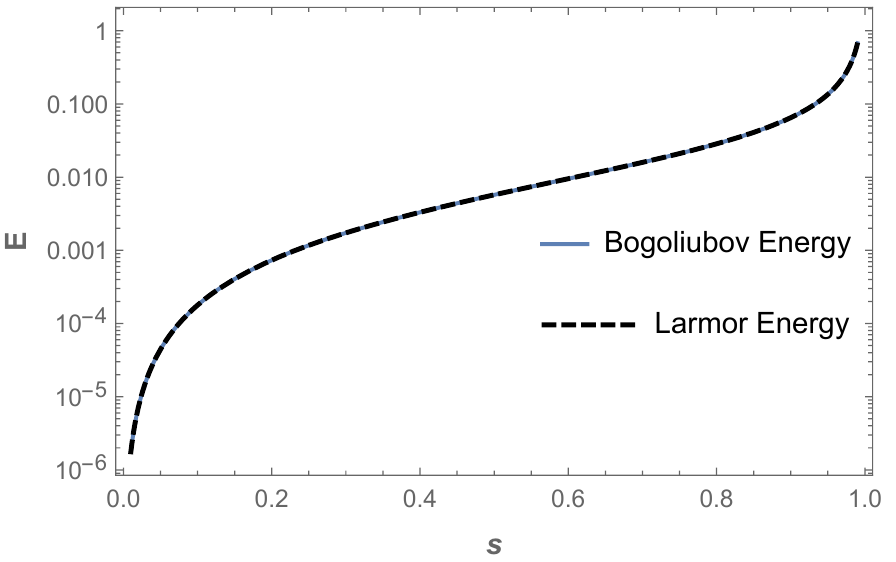
Figure 4. The Larmor energy (9) and Bogoliubov energy (5) as a function of final constant speed, s . Here, 0 < s < 0.99 and κ = 1. This plot confirms that Larmor and Bogoliubov energies are equivalent, substantiating the double-sided moving mirror as an analog model of the